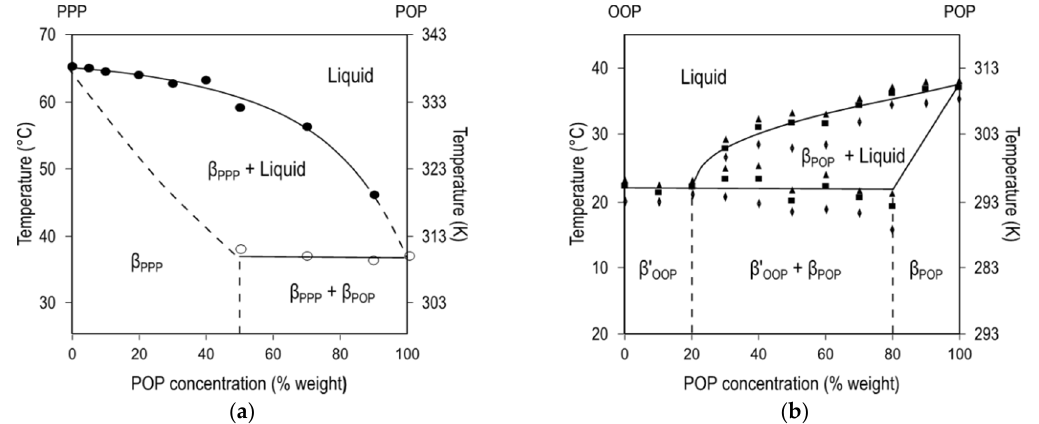
Figure 10. Stable phase diagrams of ( a ) PPP/POP and ( b ) POP/OOP binary systems. Adapted with permission from [60,118], © 1996, 2007 American Oil Chemist’s Society.